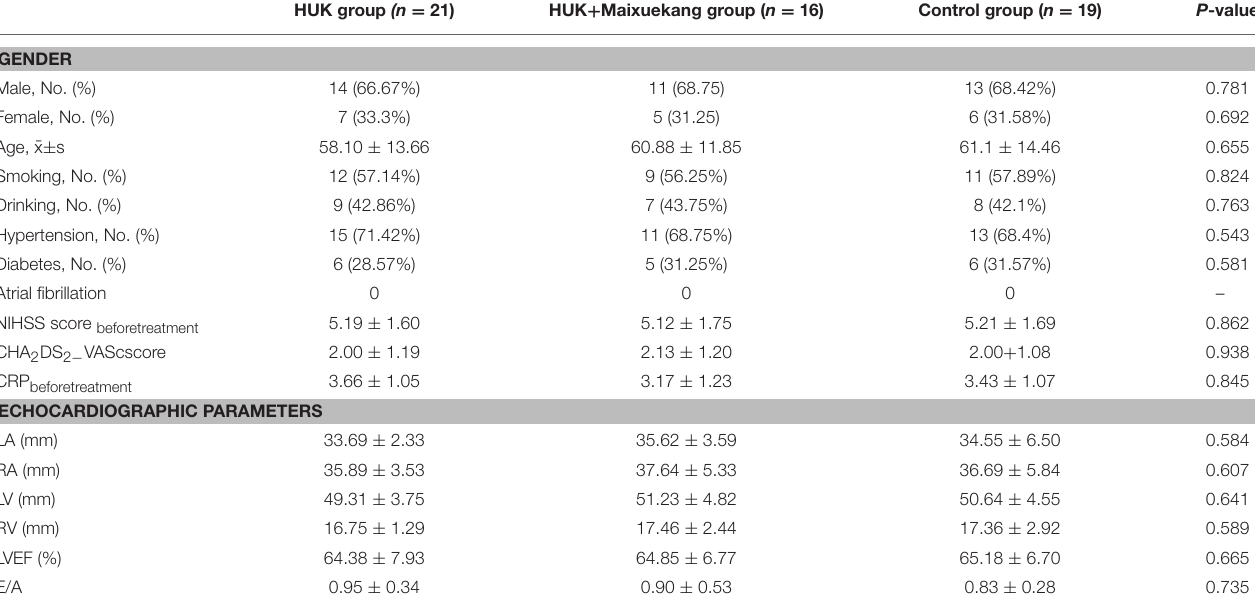
TABLE 1 | Baseline characteristics.